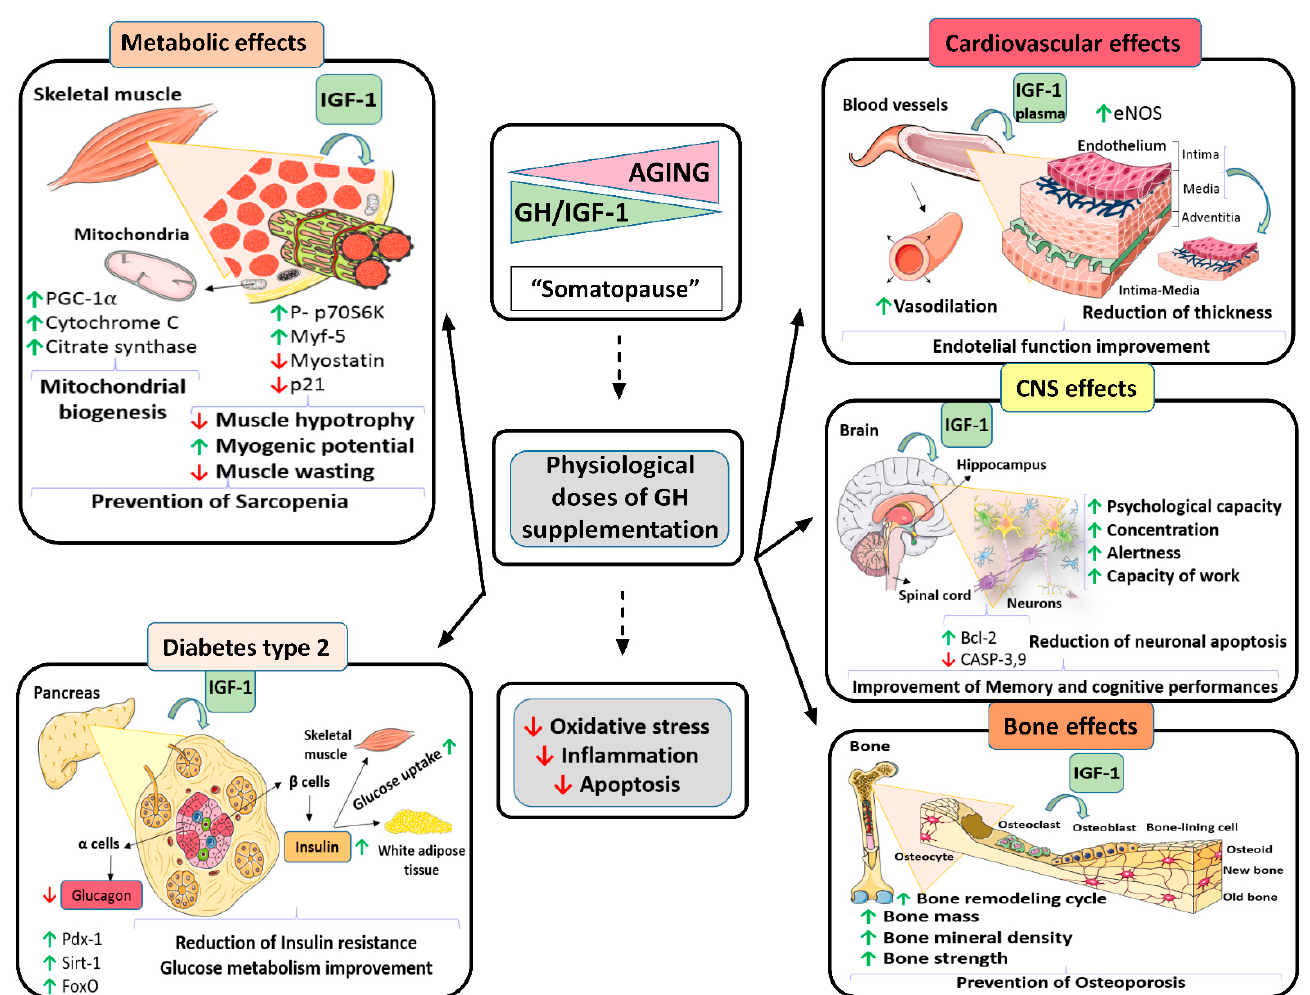
Figure 1. Beneficial effects of chronic treatment with physiological doses of GH in both old Wistar rats or senescence prone SAMP8 mice on all the different organs and functions studied. Figure created with Smart Servier Medical Art.